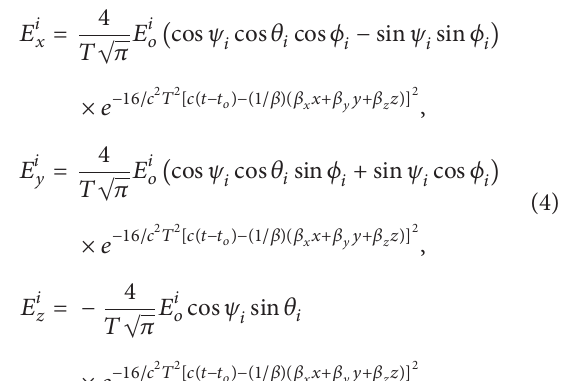
F 2: De�nition of angle of incidence and polarization of the incident plane